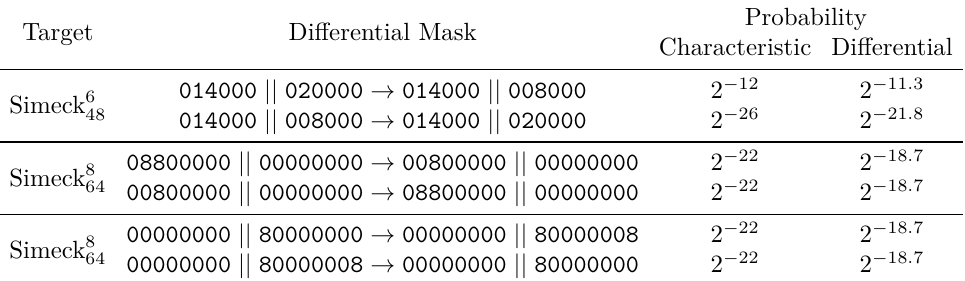
Table 2: Differential Property of Simeck for 6-Round Iterative Characteristic